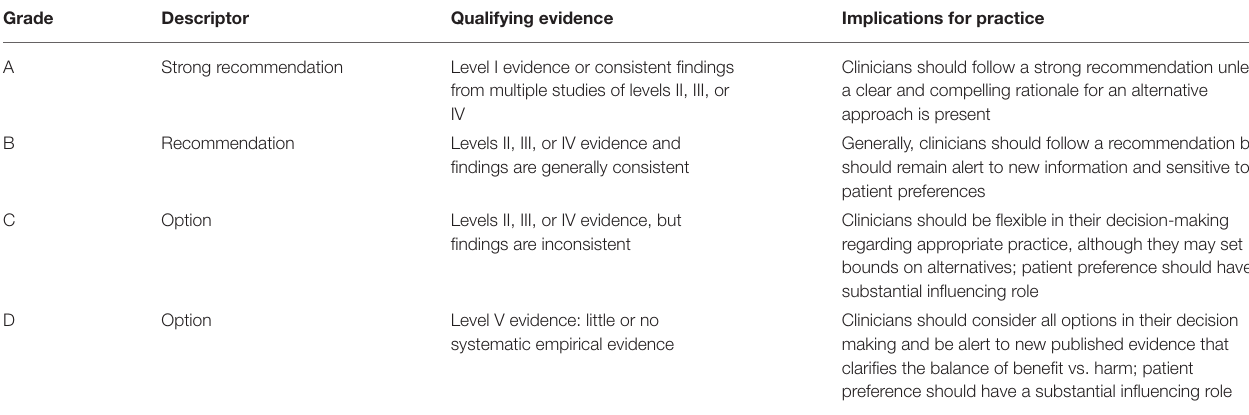
TABLE 4 | Grade practice recommendations from the American Society of Plastic Surgeons in Burns et al.